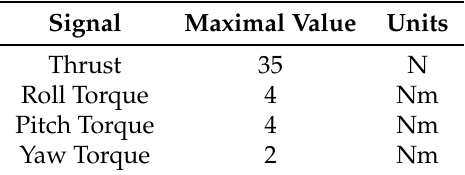
Table 4. Limitation of the control